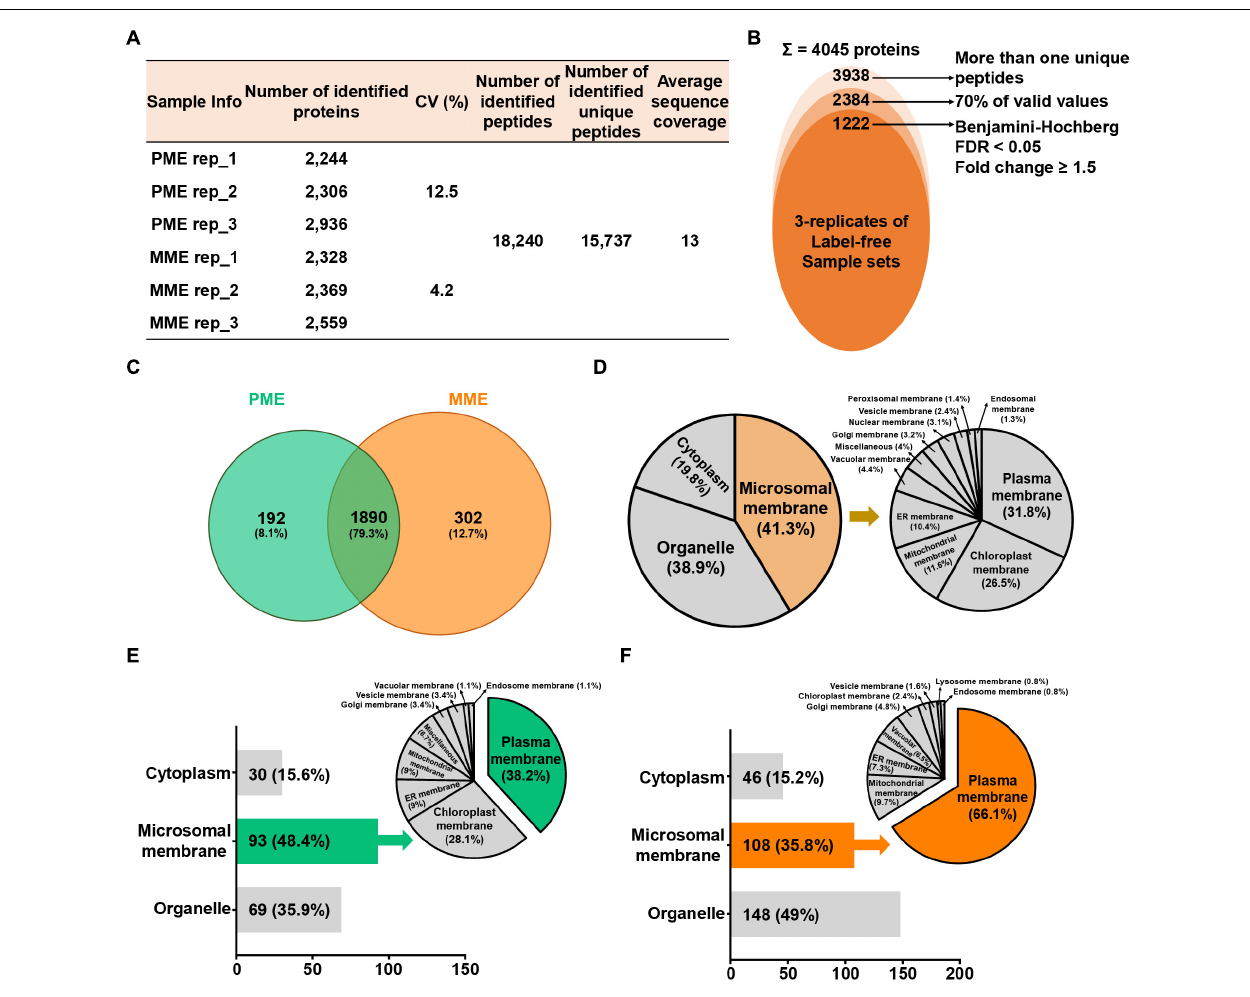
FIGURE 1 | Label-free quantitative proteomic analysis of microsomal membrane proteins (MPs) extracted from rice leaves using the MME and PME methods. (A) Table revealing the information of identified proteins in two different sample sets with replicates. (B) Circular diagram showing the distribution of the total identified and significantly modulated proteins followed by narrow down approaches. (C) Comparison and determination of subcellular localization using 2,384 identified proteins after the removal of potential contaminants. Venn diagram showing the distribution of specifically and commonly identified proteins extracted by the PME and MME methods. Subcellular localization analysis was carried out using commonly (D) and uniquely identified proteins in the PME (E) and MME (F) methods. MME, microsomal membrane protein extraction; PME, plasma membrane extraction